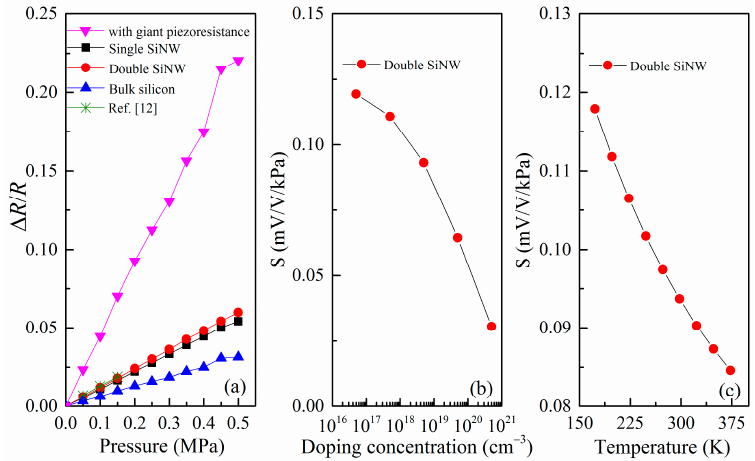
Figure 5. ( a ) Relative resistance change as a function of the applied pressure for single and double SiNW and bulk silicon; ( b ) variation of the sensitivity of double SiNW pressure sensor with the doping concentration; and ( c ) variation of the sensitivity of double SiNW pressure sensor with the temperature.